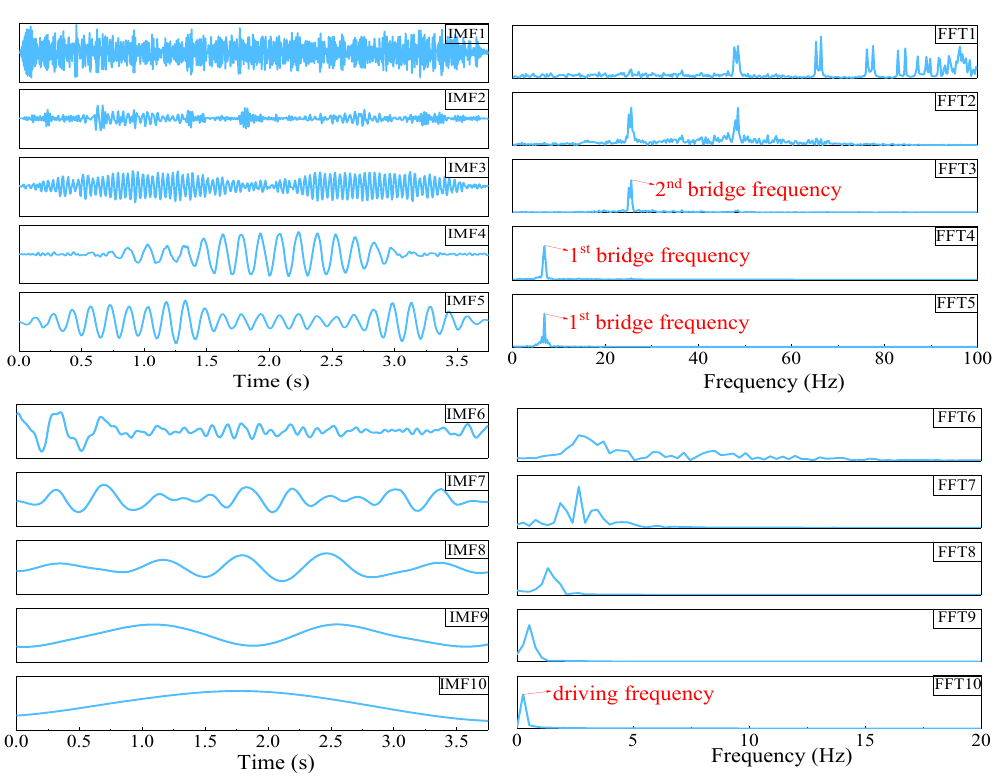
Figure 8. The IMF and FFT of the WC extracted by CEEMDAN.